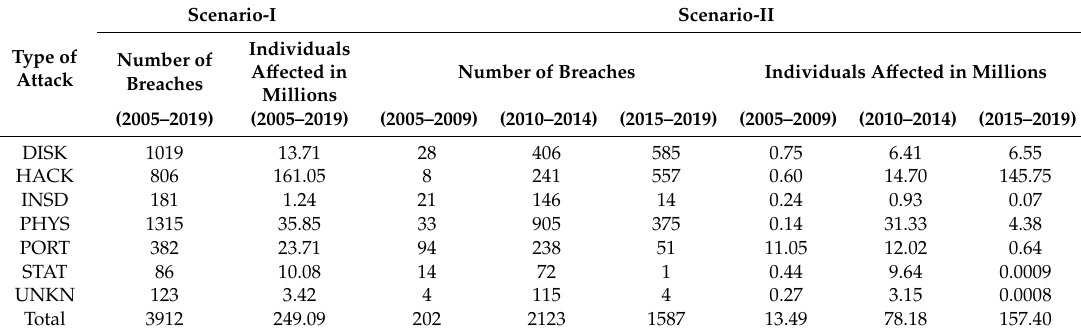
Table 2. Types of Attacks on MED Sector and Number of Individuals Affected.